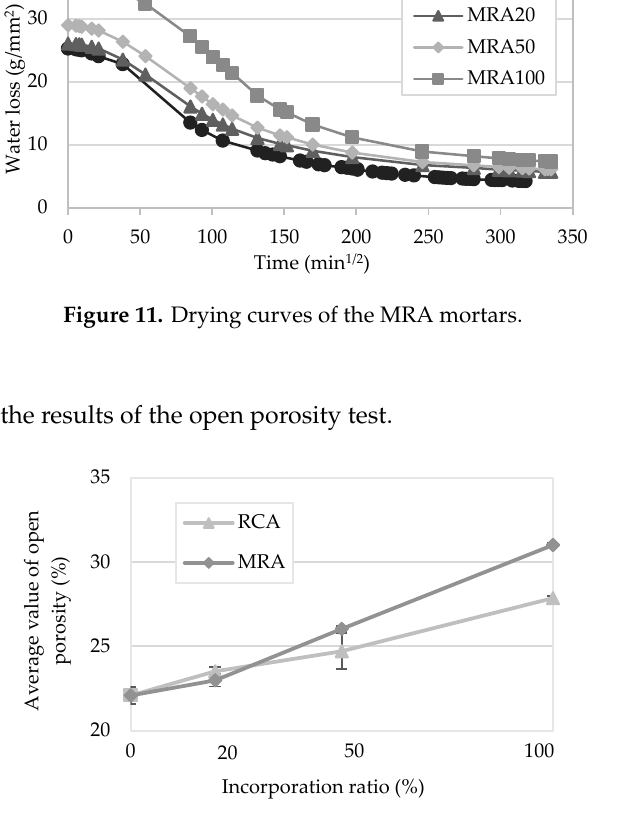
Figure 12. Open porosity of the mortars.